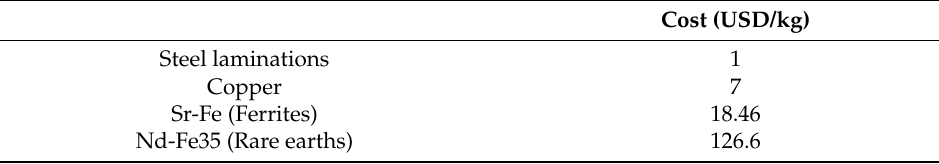
Table 3. Unit prices of active materials of RE-FRG and NRE-FRG [28].